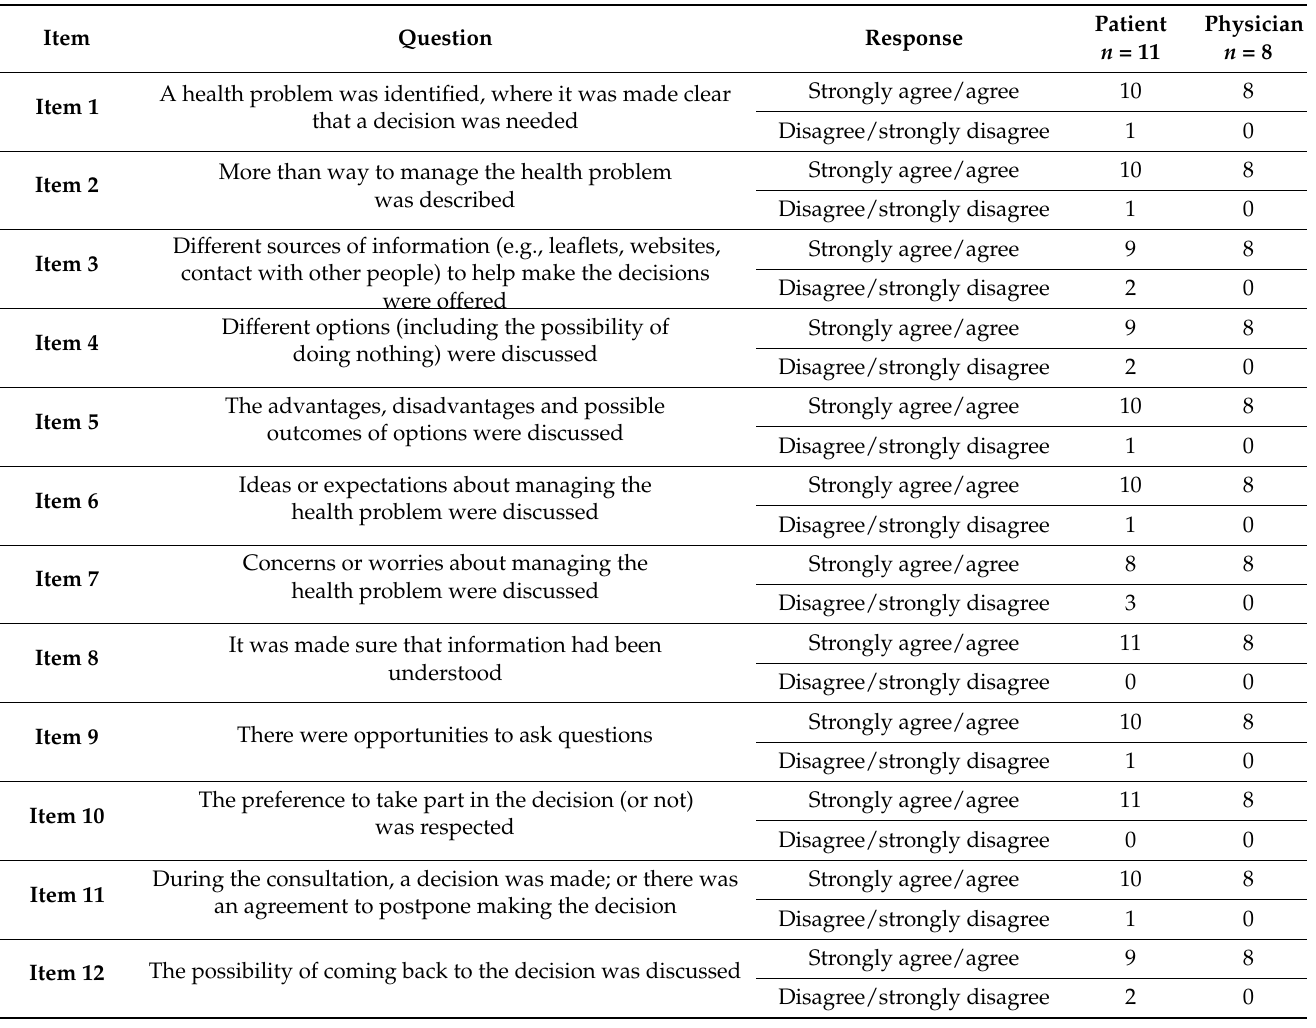
Table 7. Dyadic Shared Decision-Making OPTION